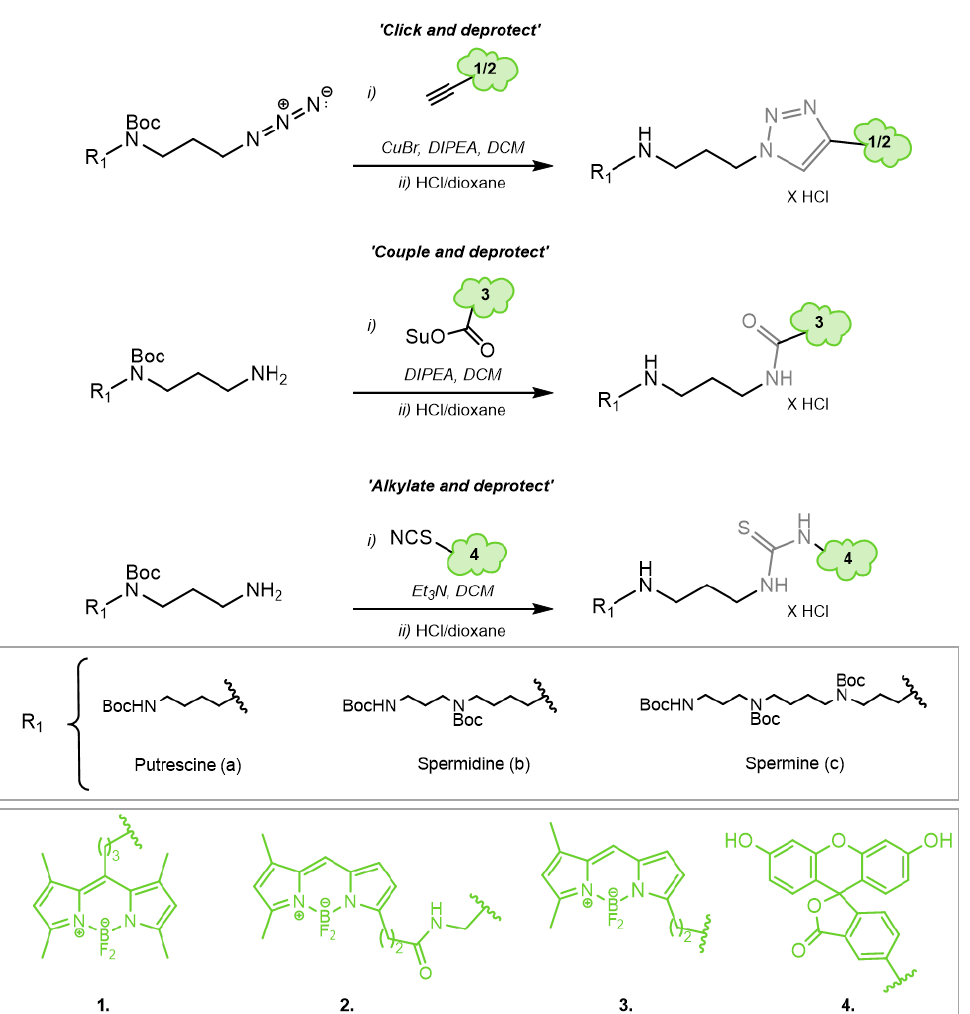
Figure 4. Simplified scheme representing the chemical synthesis of the different green fluorescent polyamine conjugates used in the study. A detailed description of the synthesis is given in Supple- mentary Information .